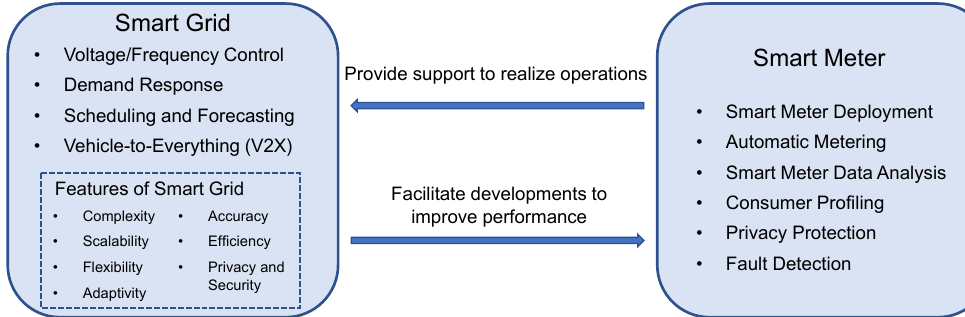
Figure 5. Applications from smart grid and smart meter